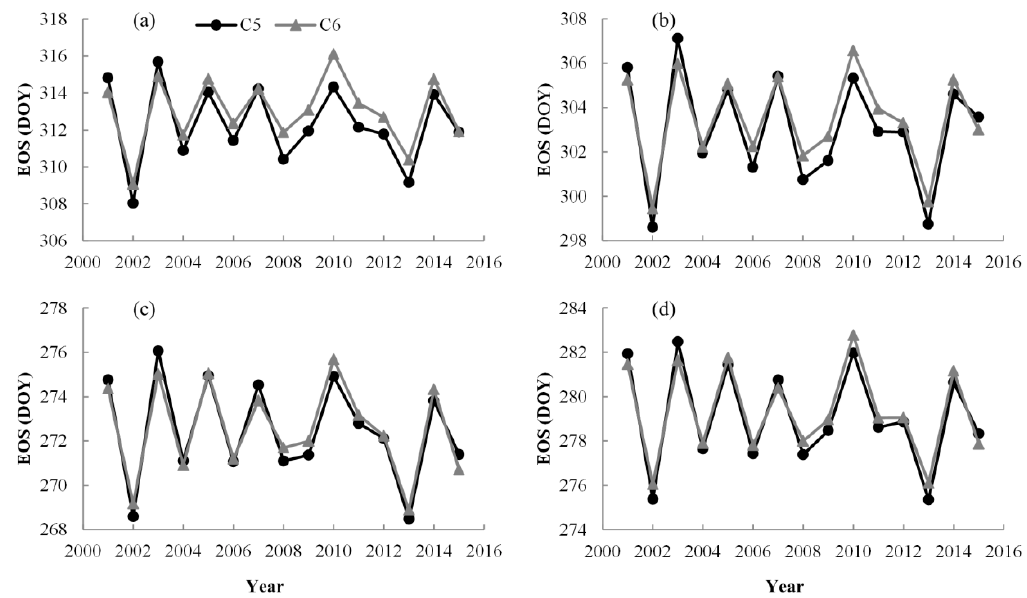
Figure 5. Comparisons of annual regional average end of growing season from MODIS C5 (SOS C5 ) and C6 (SOS C6 ) for the alpine grassland on the Tibetan Plateau during 2001–2015 for different methods: ( a ) Maximum Curvature Change (MCC); ( b ) Dynamic Threshold 0.2 (DT2); ( c ) Dynamic Threshold 0.5 (DT5); ( d ) Maximum Slope (MS). Table 3. Summary statistics for the regional average end of growing season derived from C5 and C6 Normalized Difference Vegetation Index (NDVI) products for the alpine grassland on the Tibetan Plateau during 2001–2015.